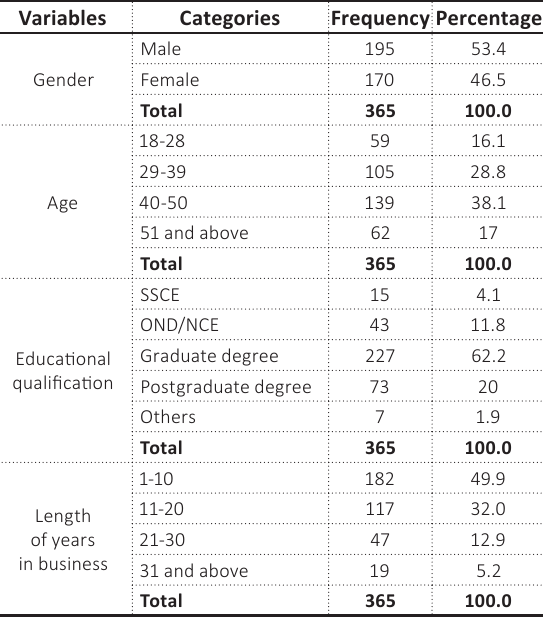
Table 2. Demographic profile of